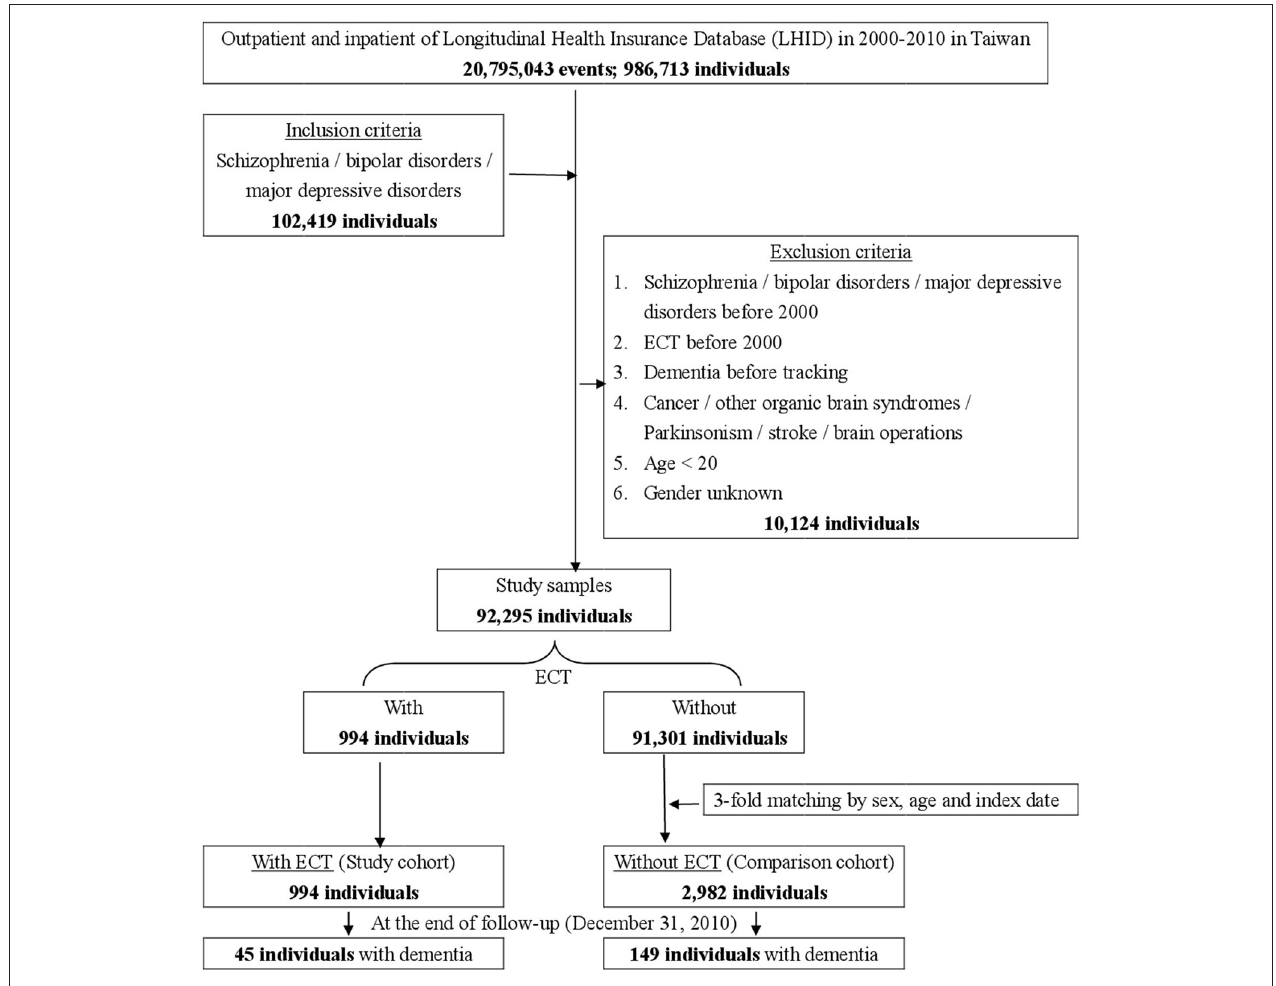
FIGURE 1 | The flowchart of study sample selection from National Health Insurance Research Database in